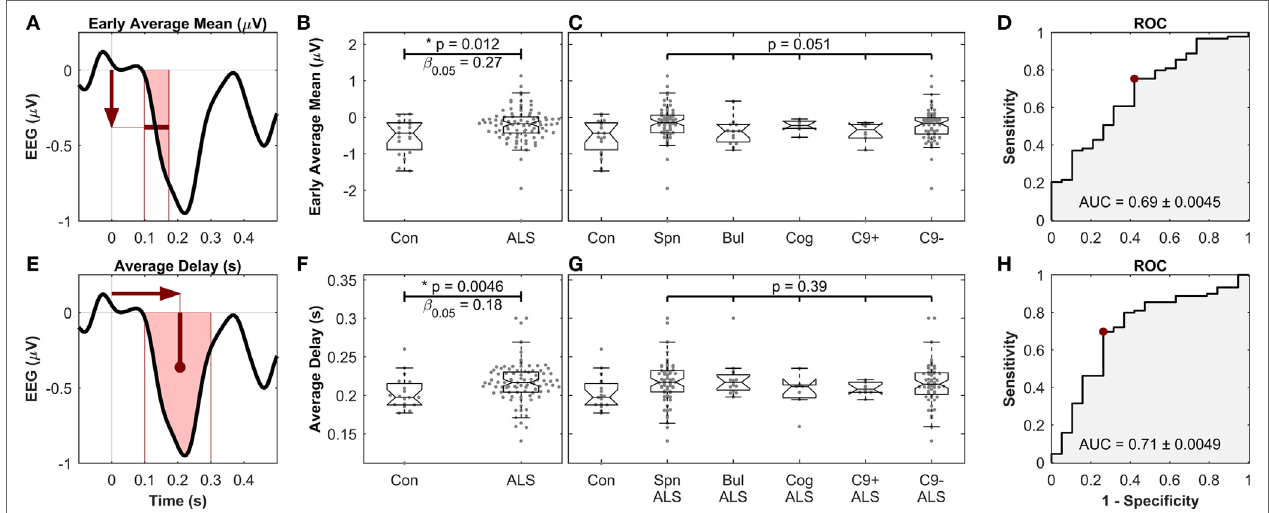
FigUre 6 | Early average mean [top, (a–D) ] as well as the average delay [bottom, (e–h) ] of mismatch negativity (MMN), showing significant differences between controls and amyotrophic lateral sclerosis (ALS) patients, but not between ALS subgroups. (a,e) Schematic of the definition of the MMN waveform measures. (b,F) Comparison between healthy controls and all ALS patients. (c,g) Comparison between ALS subgroups. “Con,” “Spn,” “Bul,” “Cog,” “C9 + ,” and “C9 − ” stand for control, spinal, bulbar, cognitive/ALF-FTD, C9ORF72 positive and C9ORF72 negative subgroups, respectively. (D,h) ROC curve, comparing the discriminatory power, the optimal level of sensitivity–specificity (red dot), as well as the area under the curve (AUC), achieved for linear discrimination of controls and ALS patients of each measure. See text for methods and